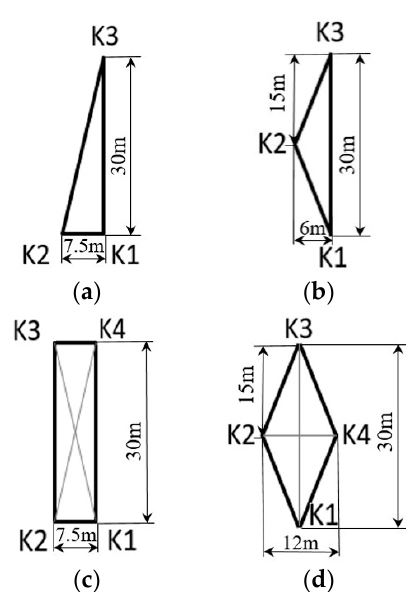
Figure 4. Four different station layouts . (a) Right triangle layout; (b) Isosceles triangle layout; ( c ) Rectangular layout; ( d ) Lozenge layout.